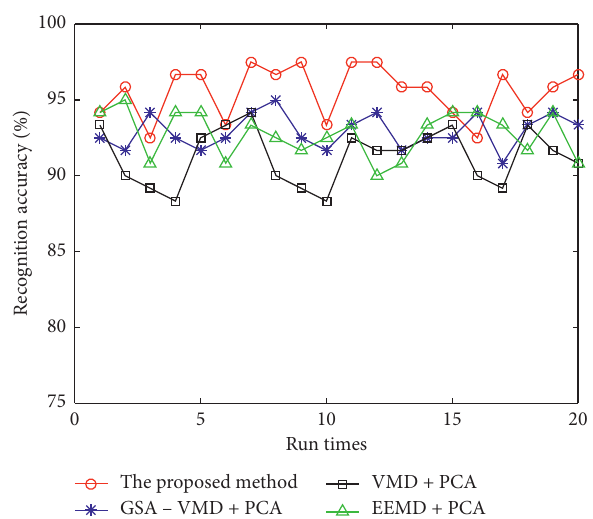
Figure 14: Recognition accuracy of the four methods. Table 6: The cutting state recognition results of the four methods. Table 8: The recognition results based on the proposed method and MRVM-based Methods